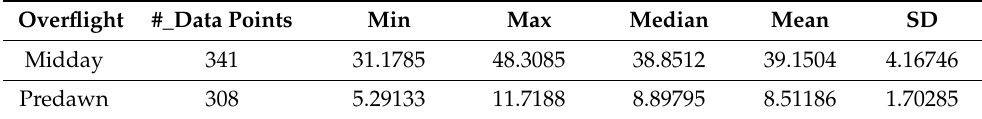
Table A4. 2010 Pisgah surface temperature statistics. Surface temperatures (in degrees Celsius) as estimated by Titus et al. [69] for the 11 sample locations, which were combined to determine statistics. Number (#) of data points is the number of temperature values taken at five-minute intervals from the 11 samples sites within the overflight time span. Minimum, maximum, median, mean, and standard deviation (SD) were derived from these temperature values.